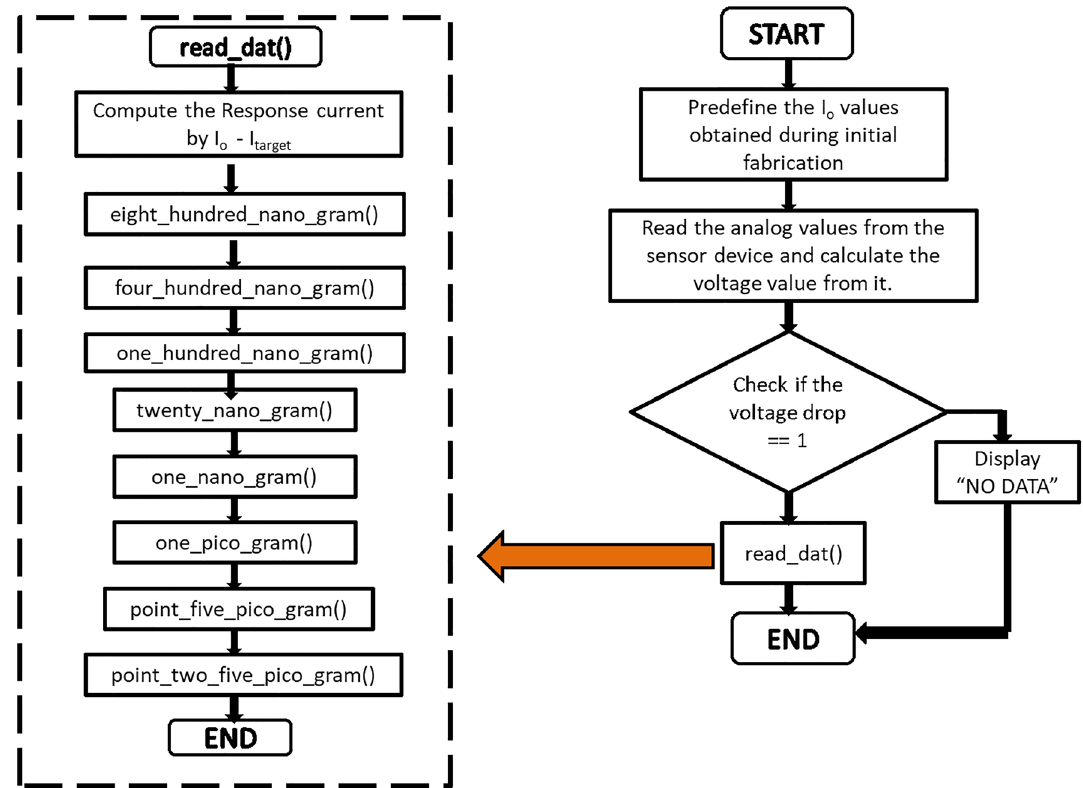
Figure 8. Flowchart of the algorithm developed for the prediction of CEA concentrations.